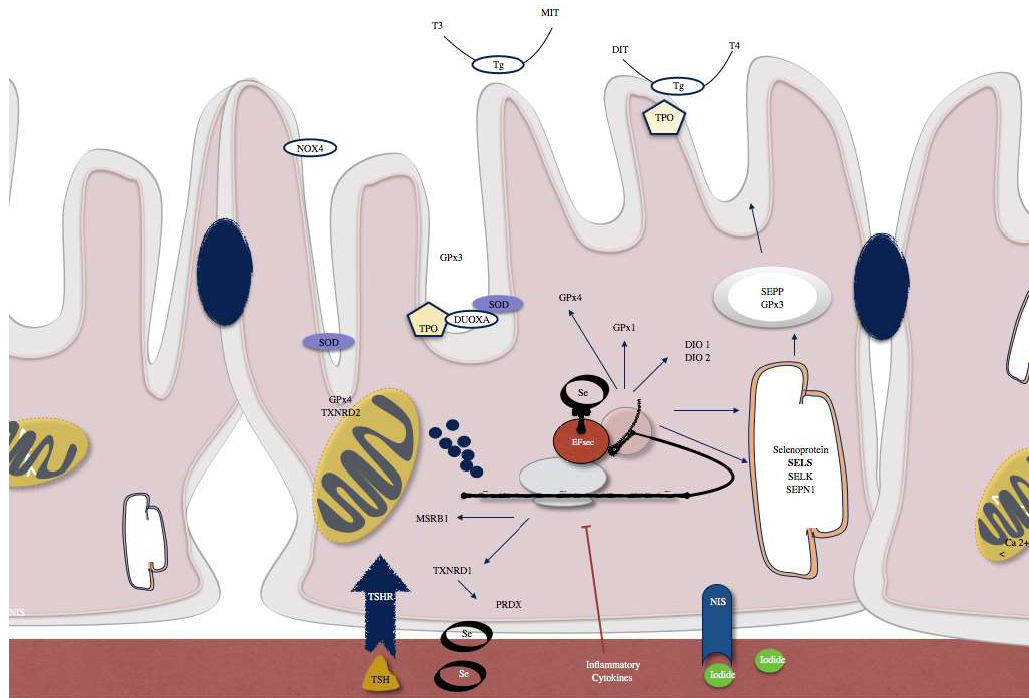
Figure 2. Examples of selenoproteins present in thyrocytes include SELENOP and glutathione peroxidase 3 (GPx3) that are actively secreted. SELENOS and SELENOK that have a role in quality control pathways within the endoplasmic reticulum (ER). Type 1 and 2 iodothyronine deiodinases (DIO1, DIO2), GPx1 and GPx4, methionine sulfoxide reductase B1 (MSRB1), selenophosphate synthetase 2 (SPS2), and thioredoxin reductase 1 (TXNRD1) are intracellular selenoenzymes. TXNRD2 and a GPx4 isozyme are localized in mitochondria. SBP2, which is a factor responsible for the selenoprotein translocation control.